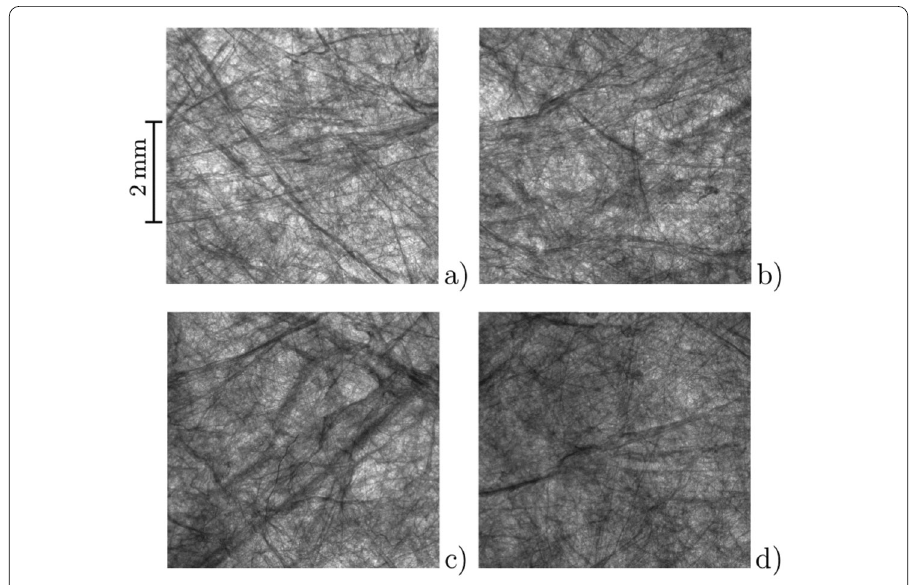
Figure 1 Four microscopic images of a nonwoven layer from a face mask. Several fields of view taken in transmission mode, 2048 × 2048 pixels of size 3.367 μ m. The total area of the four images is 190.2 mm